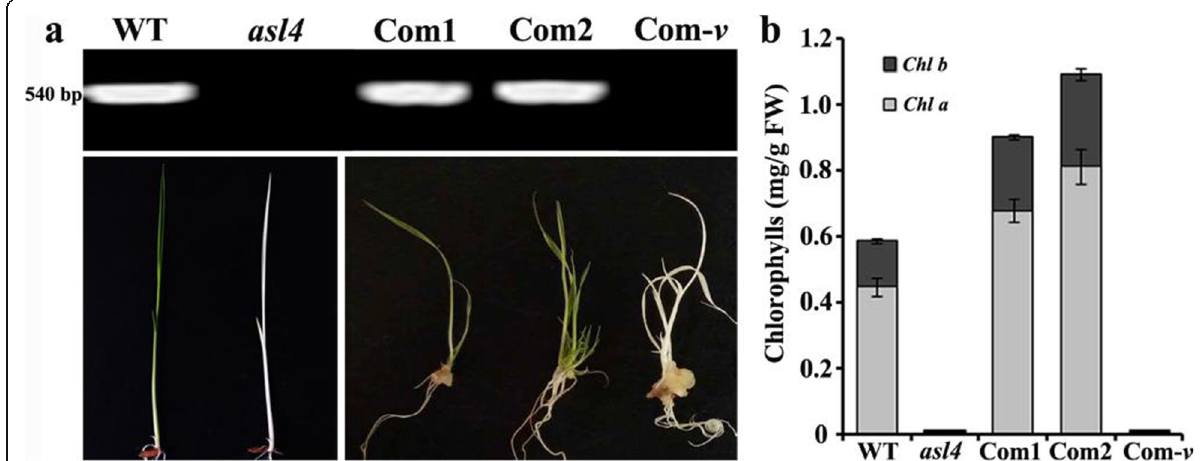
Fig. 3 Complementation test of the asl4 mutation. a Phenotypes of wild type, asl4 mutant and transgenic plants. Primer KF indicated in Fig. 2d was used to distinguish positive and negative lines. 540 bp, size of the amplified product generated by primer KF. b Chlorophyll contents of wild type, asl4 mutant and transgenic plants. Values are means ± SD from three independent repeats. Com1, Com2 and Com-v are two positive transgenic lines and transformation control with empty vector,